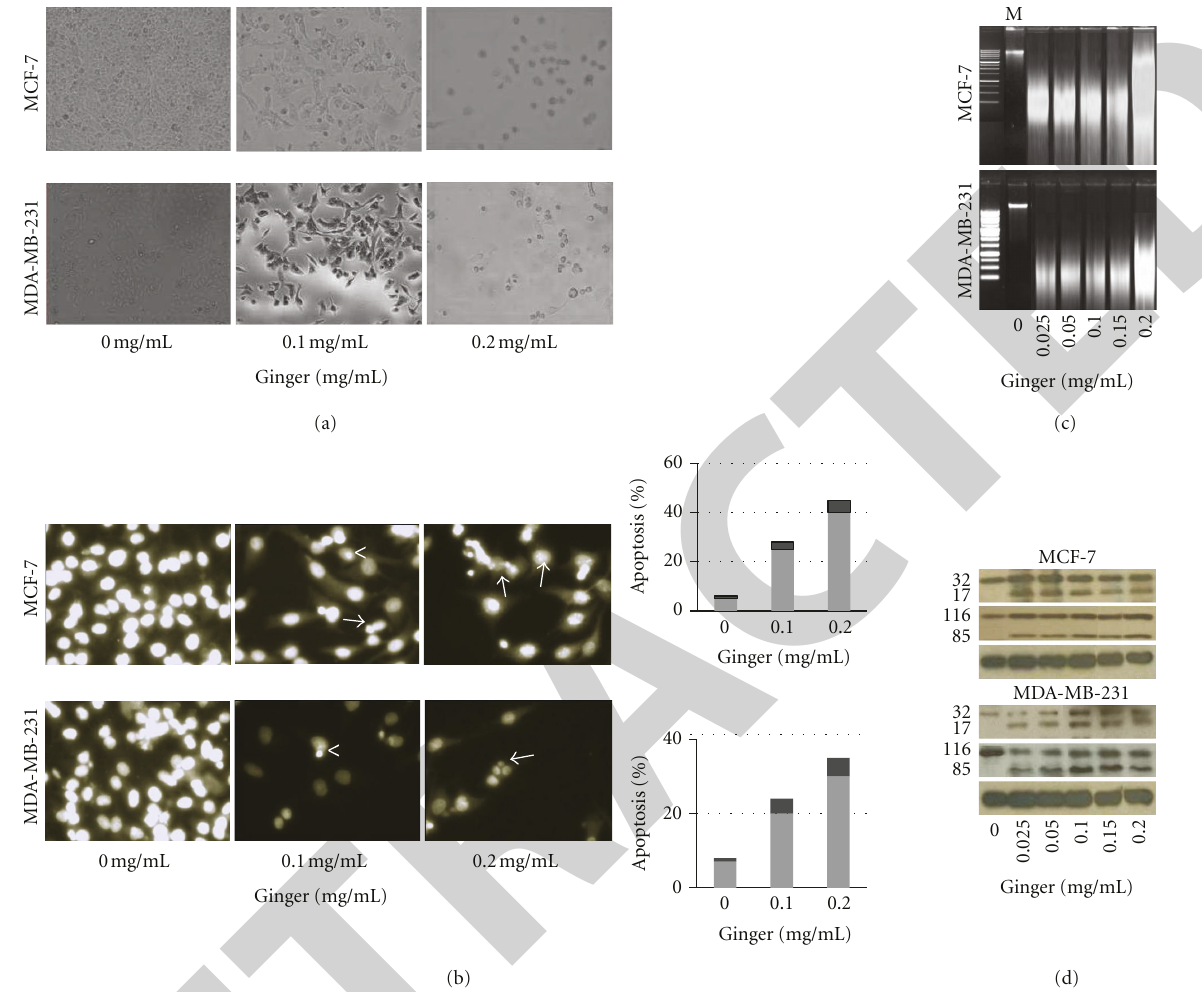
Figure 3: Ginger extract induces apoptotic cell death in MCF-7 and MDA-MB-231 cells. (a) Microphotographs showing the inhibitory e ff ect of gingerextract on cellular growth of MCF-7 and MDA-MB-231 cells. Cells were plated onto 6-well plates and treated with indicated concentrations of ginger for 24 h. The photographs were taken directly from culture plates using a phase microscope. Note cell shrinkage, irregularity, and detachment in ginger-treated cultures. Representative pictures are shown from three independent experiments. (b) DAPI staining for MCF-7 and MDA-MB-231 cultures treated with ginger extract for 24h. Note apoptotic cells with condensed chromatin ( < ) and fragmented nuclei ( → ) were clearly visible in ginger-treated, but not in control-treated, cultures. Histogram panels show quantitation of apoptotic cells with condensed chromatin in ginger-extract treated-MCF-7 and MDA-MB-231 cultures. Columns, mean of six to nine determinations. (c) The ginger extract treatment induced DNA fragmentation in MCF-7 and MDA-MB-231 cells. Cells were incubated with indicated concentrations of ginger extract for 24 h. Genomic DNA was isolated and electrophoresed in 1% agarose gel. M: 100 bp DNA ladder marker. (d) The ginger extract treatment increased the cleavage of caspase-3 (upper panel) and PARP (middle panels) in MCF-7 and MDA-MB-231 cells. Cells were treated with indicated concentrations of ginger extract for 24h; thereafter, cell lysates were prepared and analyze by Western blot as detailed in Section 2, for detecting the cleavage of caspase-3 and PARP using. Equal loading of samples was confirmed by β -actin (lower panels); representative blots are shown from three independent experiments with almost identical